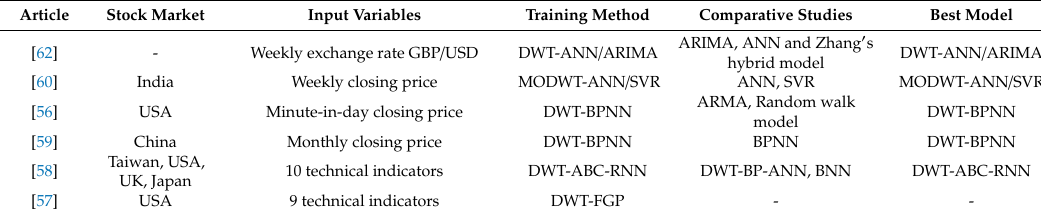
Table 4. Summary of discrete wavelet transform (DWT)-based prediction methods used by this study’s